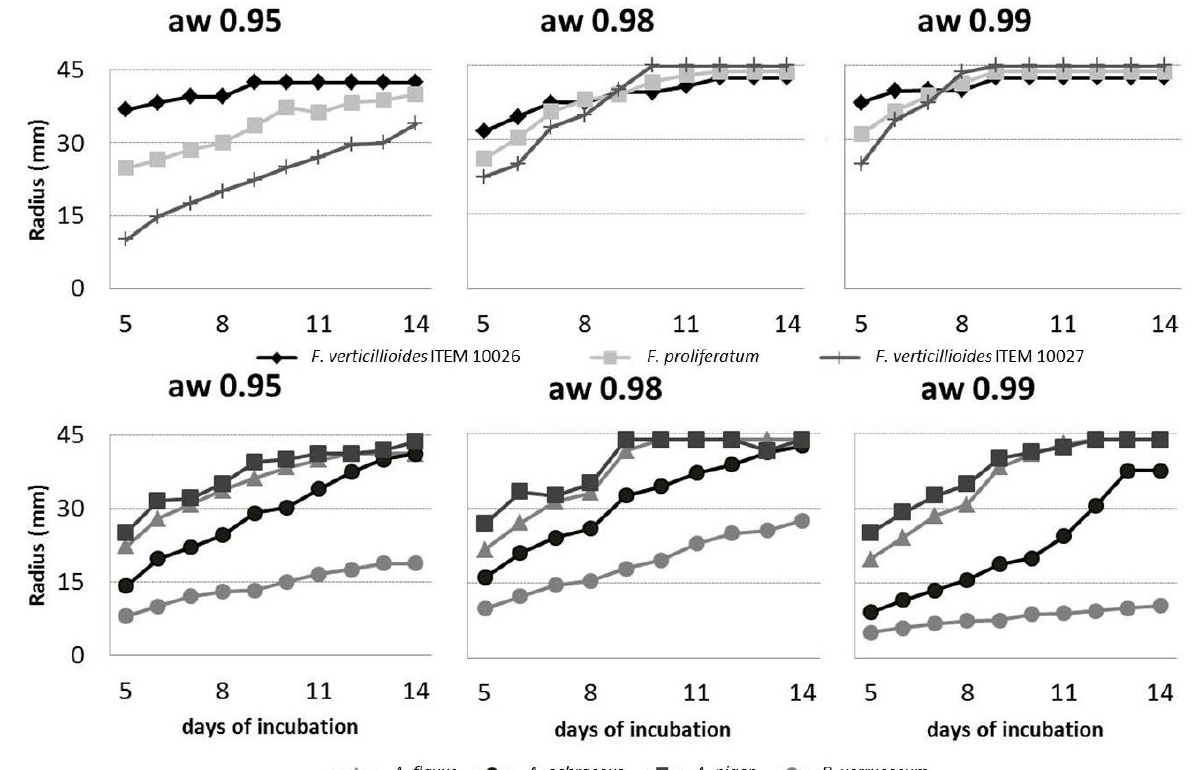
Figure 1. Fungal growth registered for Fusarium verticillioides , F. proliferatum , Aspergillus flavus , A. ochraceus , A. niger and Penicillium verrucosum during incubation of 14 d at 25°C.